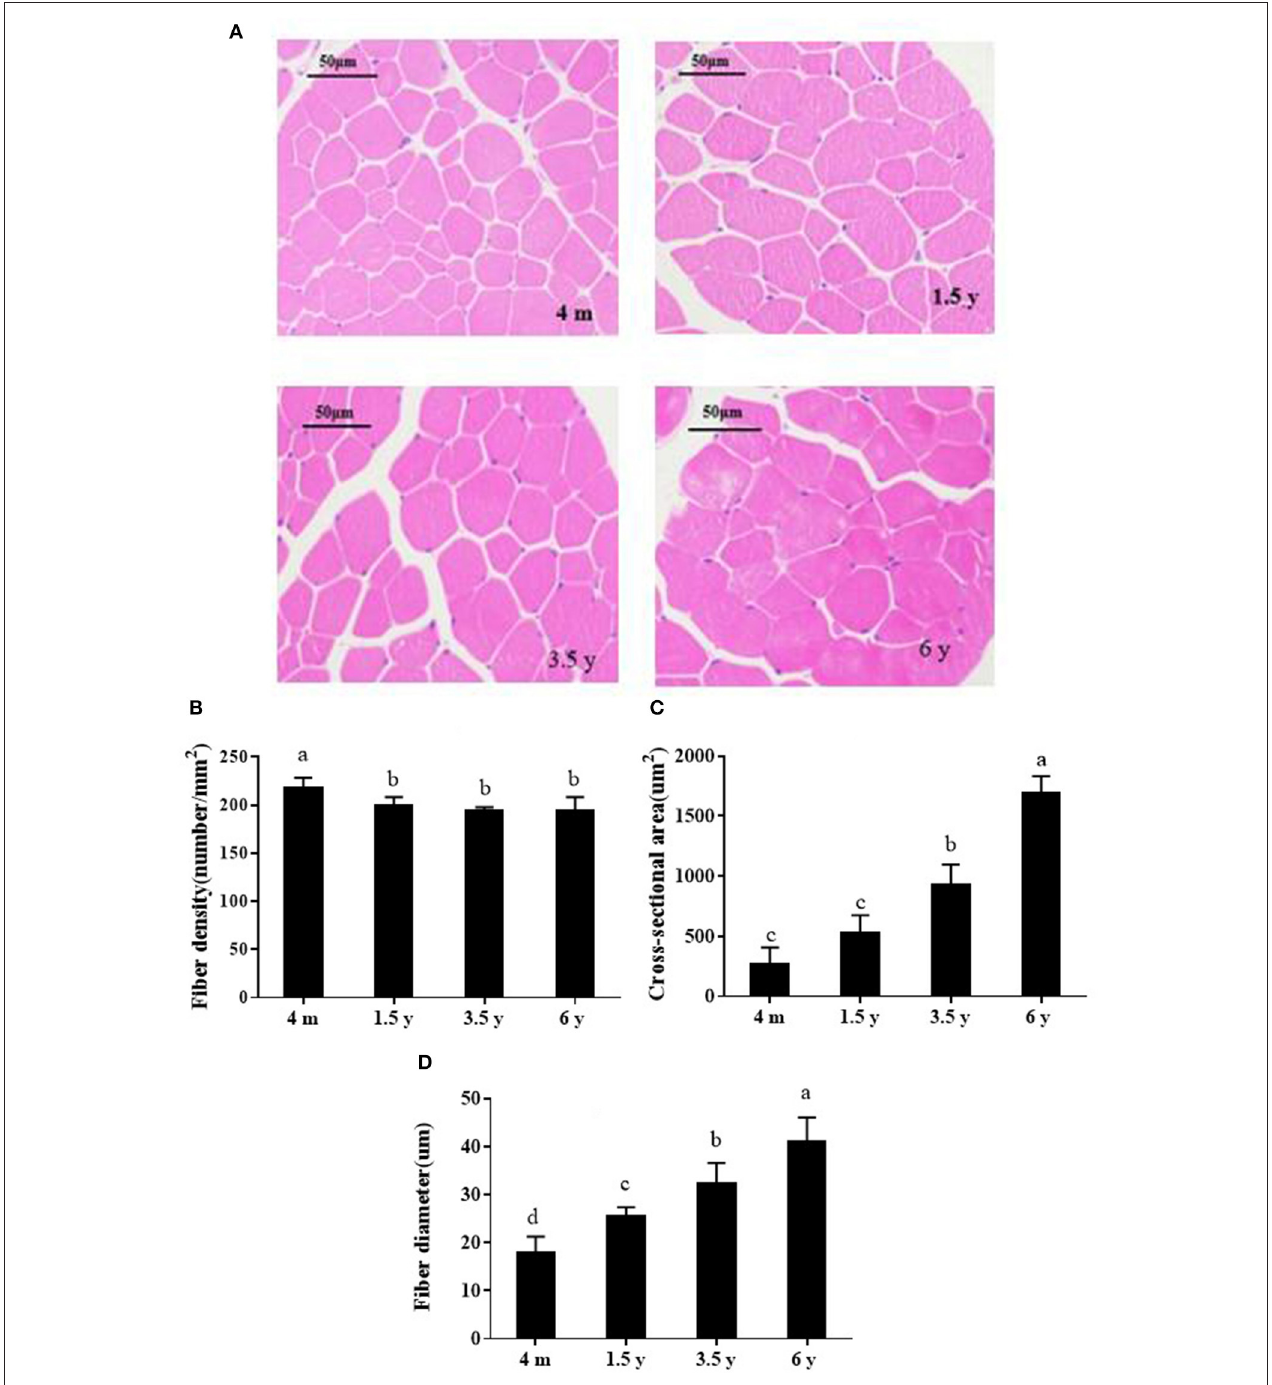
FIGURE 1 | (A) HE-stained photos of the muscle fibers of Tibetan sheep at different growth stages ( × 200). (B–D) Show muscle fiber density, area and diameter, respectively. Data are shown as the means ± S.E. Different letters (a–d) indicate significant differences between different growth stages ( p < 0.05). 4m, 4 months old; 1.5 y, 1.5 years old; 3.5 y, 3.5 years old; 6 y, 6 years old.